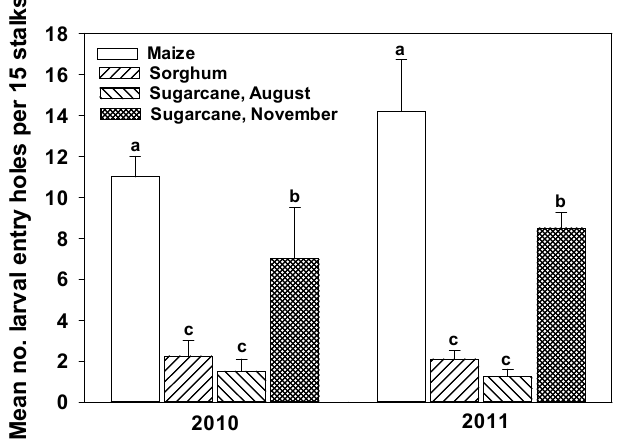
Figure 5. Mean (± SE) numbers of E . loftini larval entry holes in maize, sorghum, and sugarcane on the harvest date for maize and sorghum (in August) and in sugarcane on the harvest its date (in November), field plot assay, Hidalgo Co., TX, USA; different letters over bars within each year indicate significant differences ( p < 0.05) [52]. Table 2. Bt maize varieties and the pests against which they are registered [151].